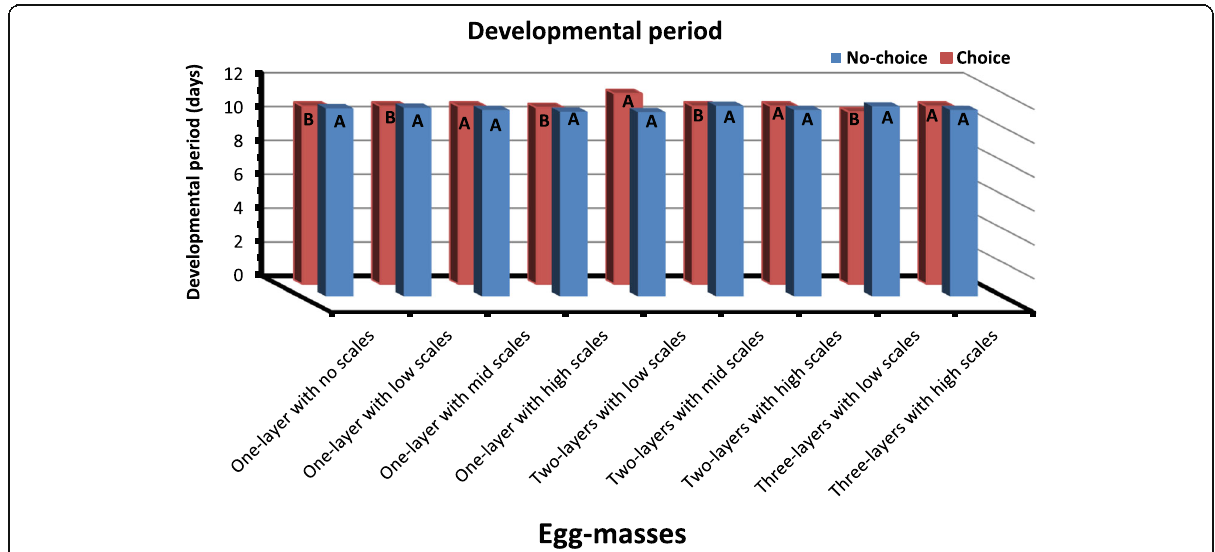
Fig. 2 Developmental period (days) of T. bactrae from S. littoralis egg masses with different physical characteristics in a no-choice and choice tests. Means denoted different letters between both tests are significantly different ( P <